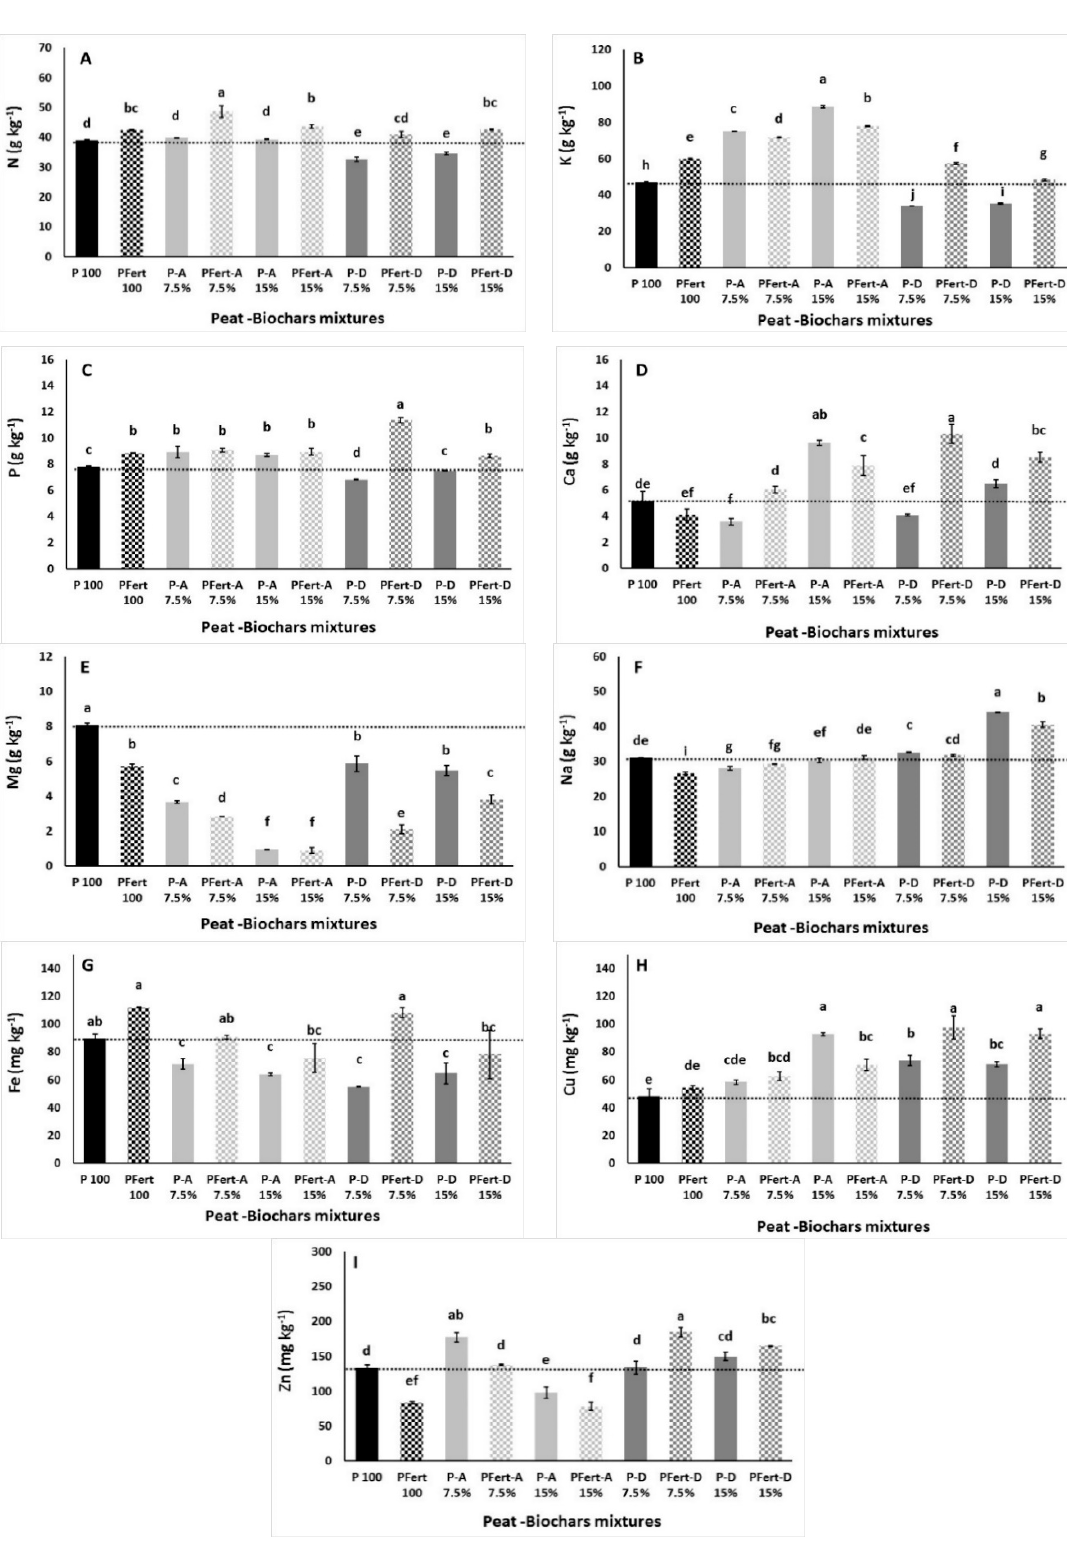
Figure 4. Effects of peat (P 100) with different biochar types (A, D) and ratio (7.5%, 15%) and mineral doses (with standard or with additional Fertilizers-Fert.) on cabbage macro ( A – F ) and micronutrient ( G – I ) content. Significant differences ( p < 0.05) among treatments are indicated by different letters. Error bars show SE ( n = 4). Dotted line present the levels of control treatment (100% peat).